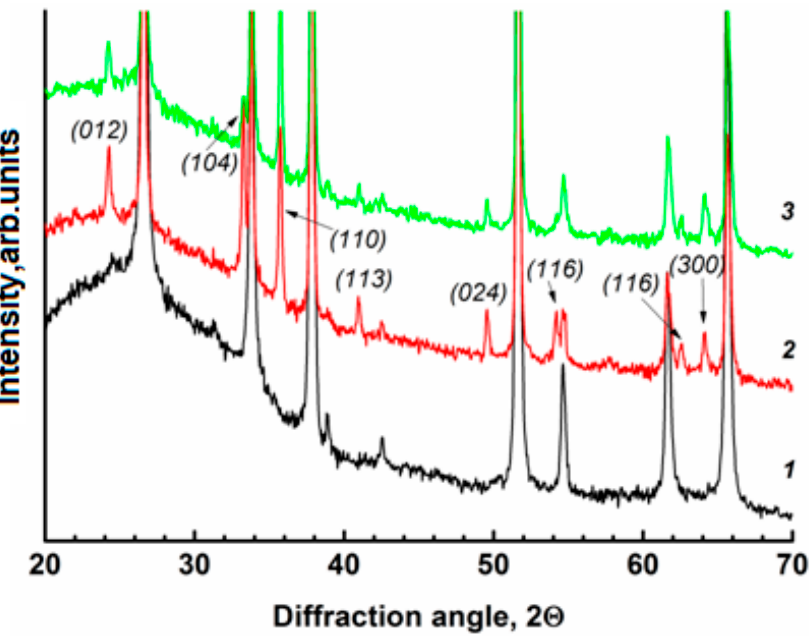
Figure 1. X-ray diffraction patterns of the samples: (1) conductive glass F:SnO 2 (FTO); (2) Fe 2 O 3 /FTO; (3) Ti 4+/ Fe 2 O 3 /FTO. The curves are displaced vertically for clarity. Diffraction peaks of hematite ( α -Fe 2 O 3 ) are marked (ICDD card 33-0664).